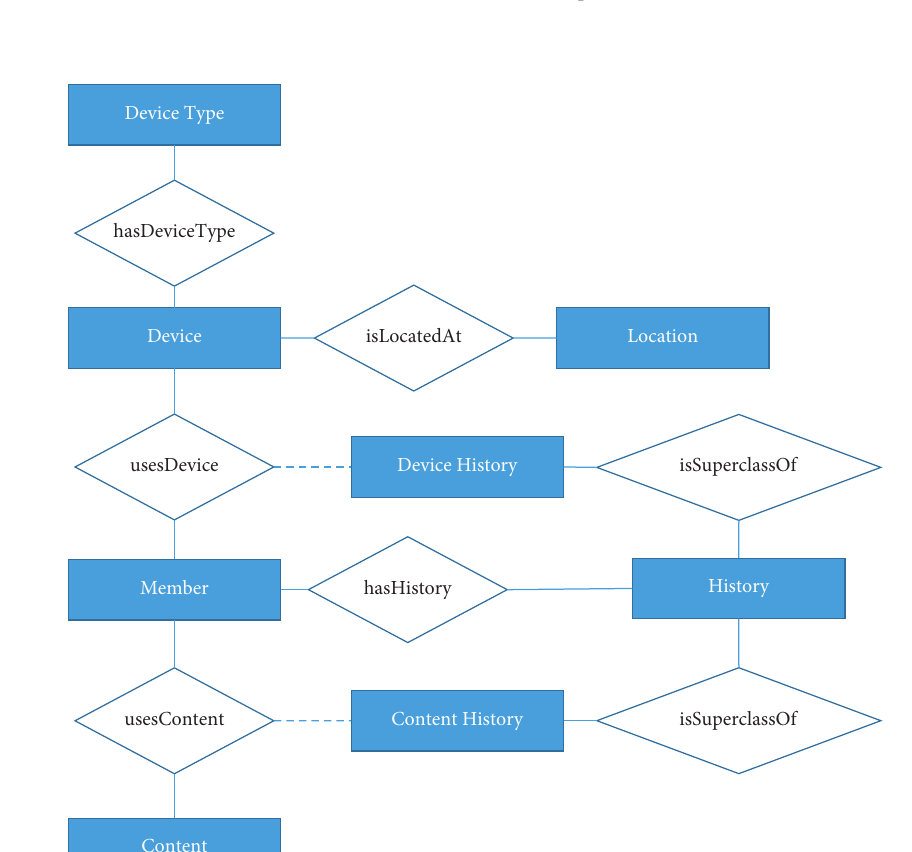
Figure 4: Meta-model of the